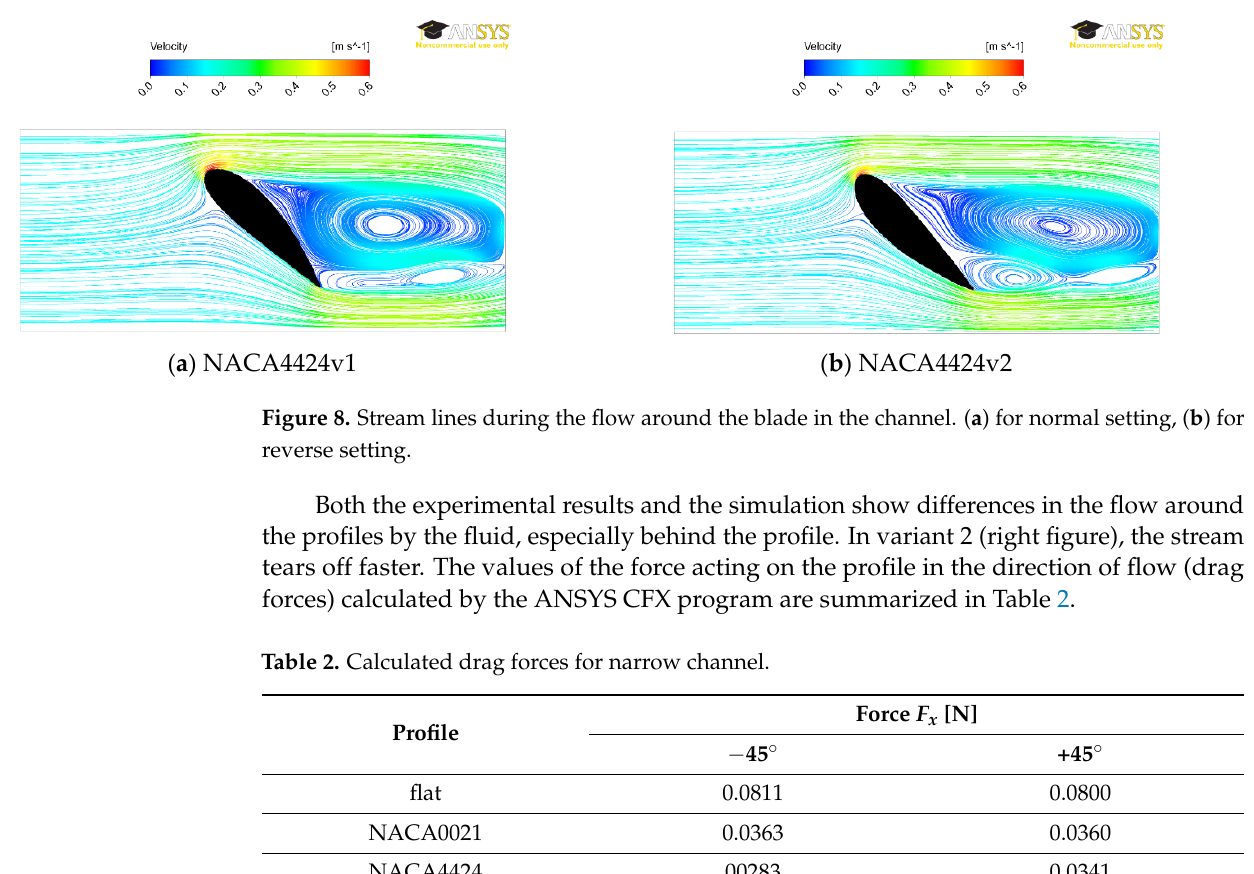
Table 3. Calculated drag coefficients.